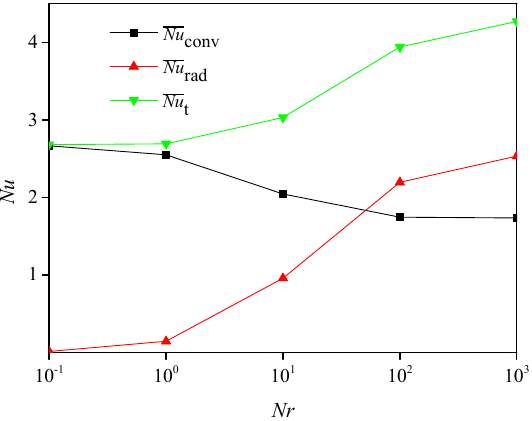
Figure 11. Variations of the average Nusselt number as a function of Nr.